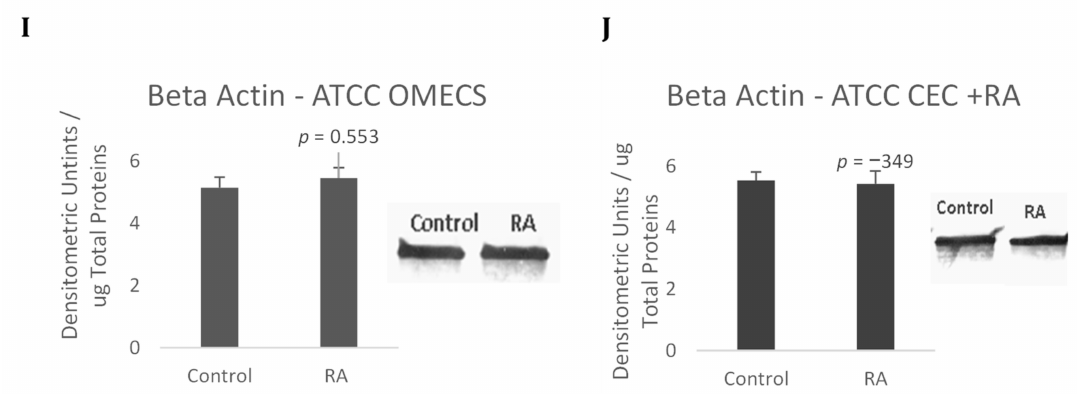
Figure 5. Cultured human oral mucosal and corneal epithelial cells (respectively, hOMECS and hCEC) were treated with retinoic acid (RA) for 24 h. Cells were harvested and analyzed for the expression levels of ALDH1A3 ( A , B ), ALDH1A1 ( C , D ), Pax-6 ( E , F ), Vimentin ( G , H ) and Beta actin for protein loading controls ( I , J ). Values are shown as Mean ± SEM, n = 3. All Pairwise Multiple Comparison Procedures were done using Student-Newman-Keuls Method.